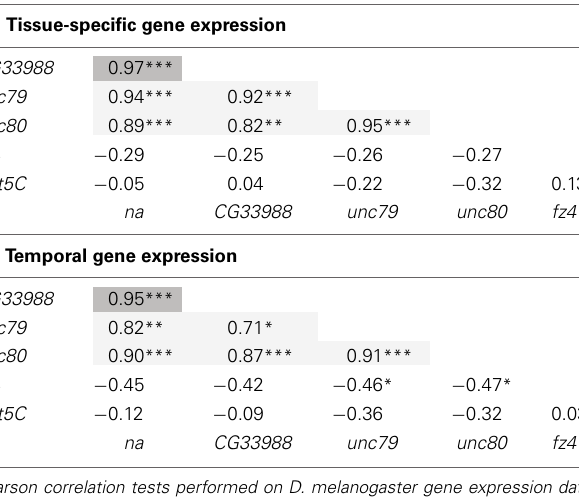
Table 1 | Gene expression correlation analysis of na and related genes.